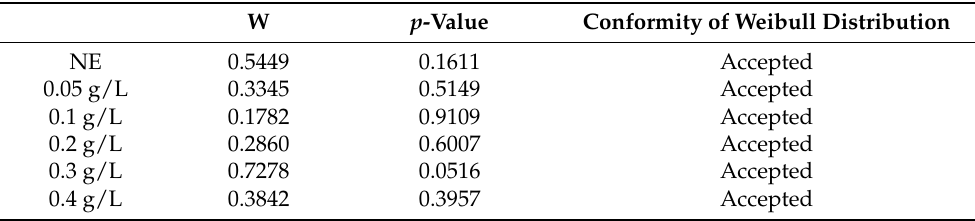
Table 2. Hypothesis test of conformity to Weibull distribution of NE and NFs.